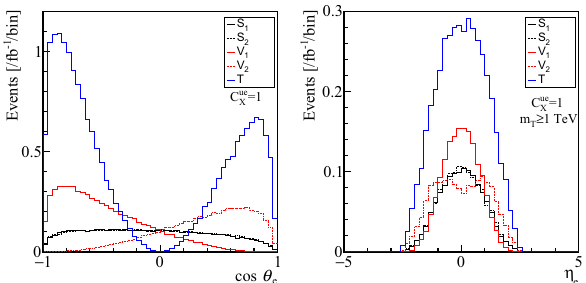
Fig. 6 (Left)Thecos θ distributionsforNPsinthe bu → e ν modewith M NP = 100TeV( C X = 1).(Right)Thecorresponding η e distributions with the additional cut of m T >